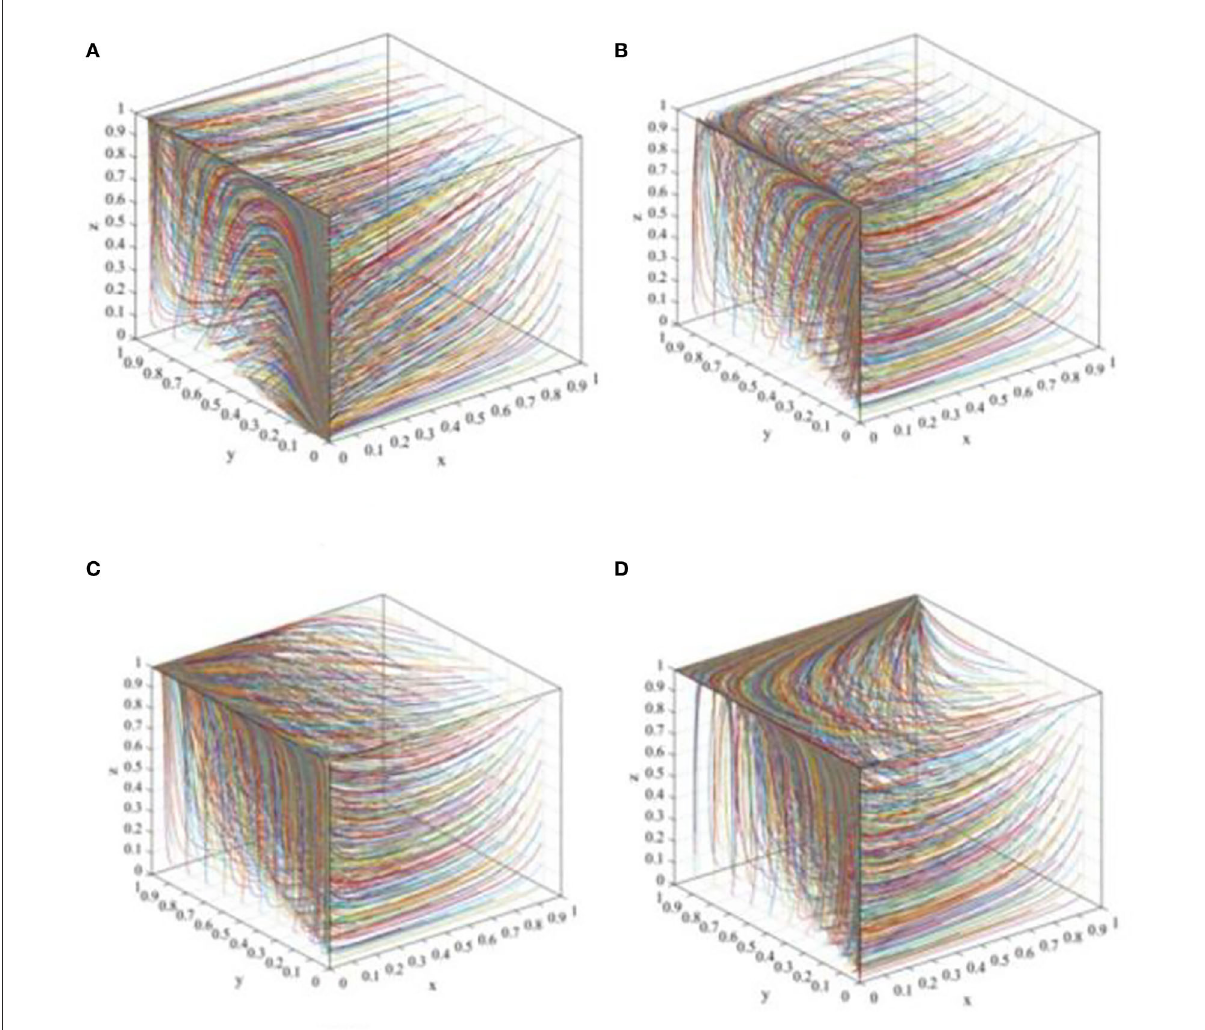
FIGURE3 The evolutionary path diagram of the three participants in different scenarios. (A) The evolutionary path at the equilibrium point E 1 (0,0,0); (B) The evolutionary path at the equilibrium point E 4 (0,0,1); (C) The evolutionary path at the equilibrium point E 5 (0,1,1); and (D) The evolutionary path at the equilibrium point E 8